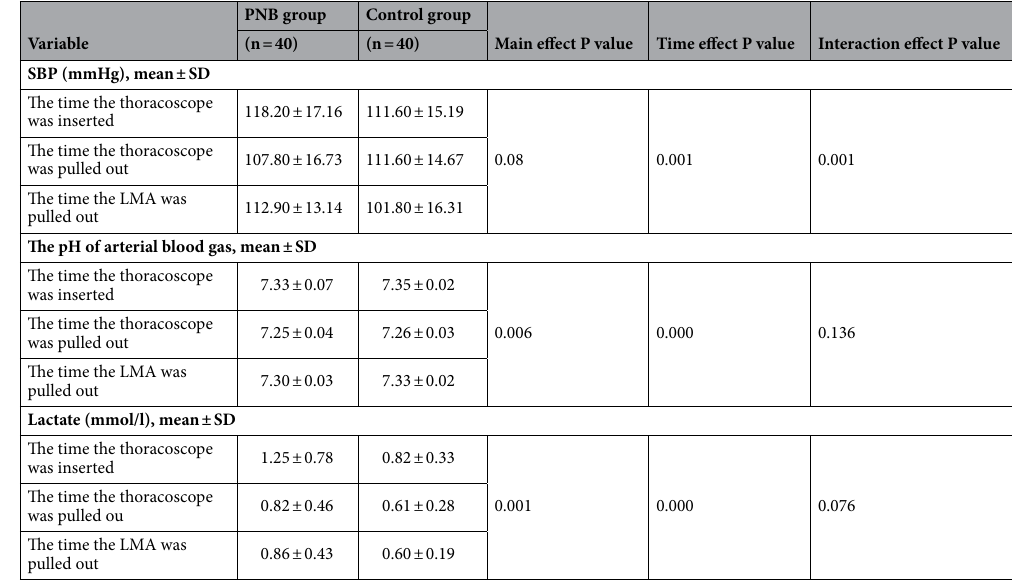
Table 4. SBP, arterial pH and blood lactate measured at three different perioperative time points. PNB phrenic nerve block, SD standard deviation, SBP systolic blood pressure.